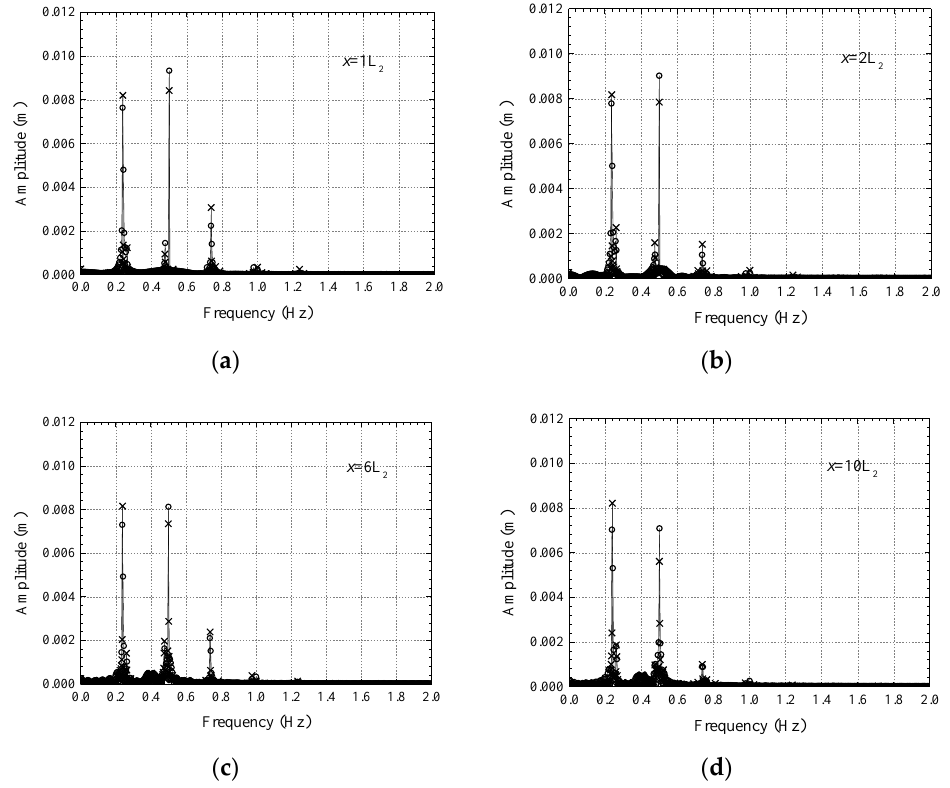
Figure 10. Frequency domain plots of wave simulation results at X = 1L 2 ( a ), X = 2L 2 ( b ), X = 6L 2 ( c ), X = 10L 2 ( d ) for the MIKE 21 BW model ( ○ ) and the Navier – Stokes model ( ╳ ) (operating condition C2).